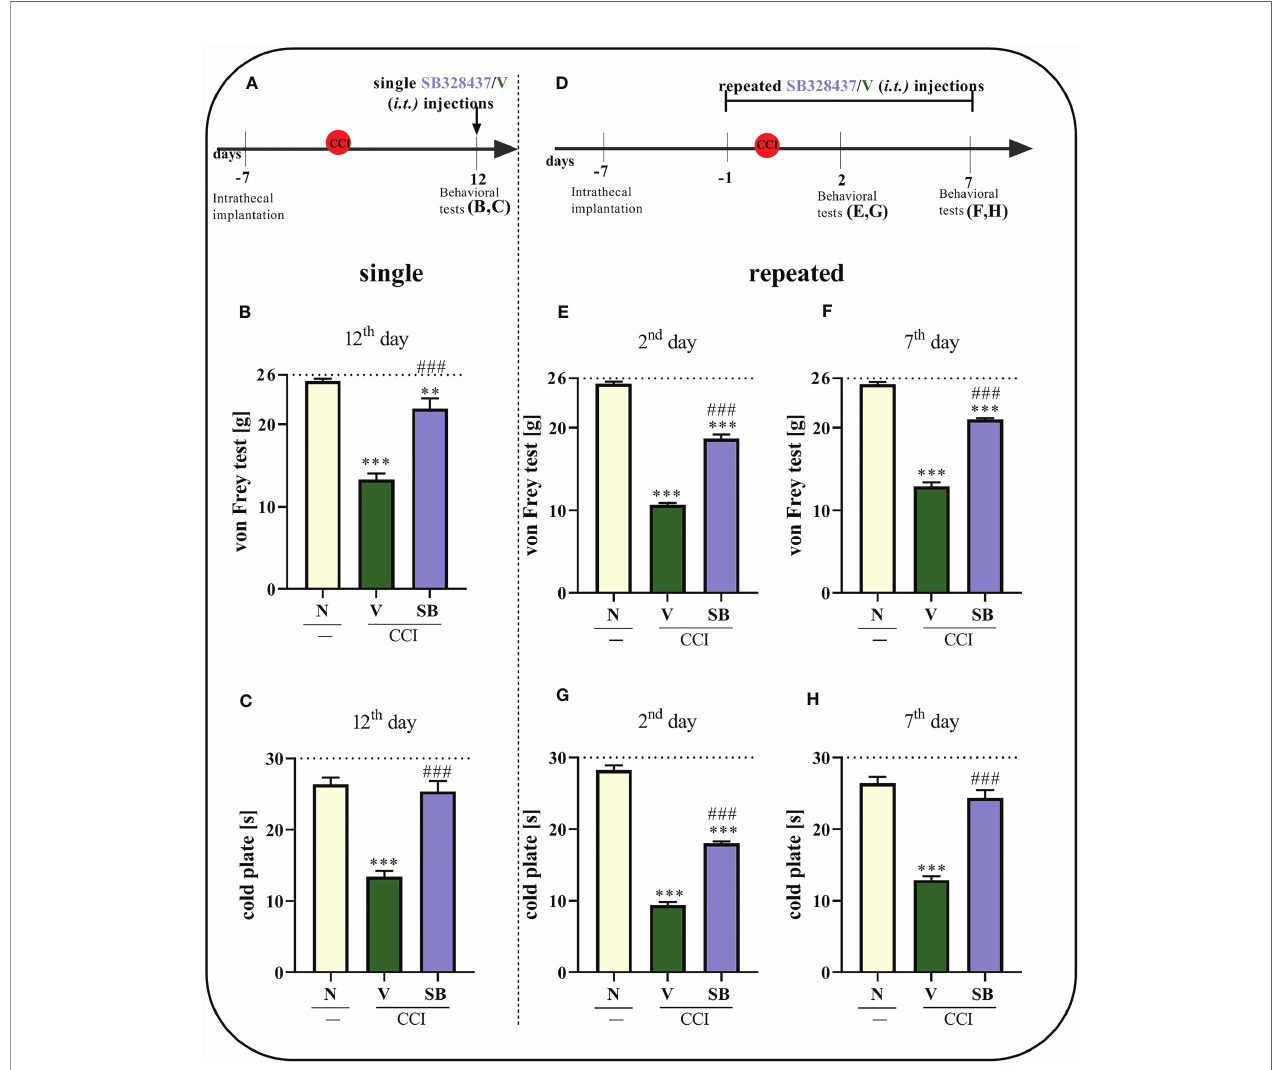
FIGURE 3 | Effect of a single administration of SB328437 [SB, 10 m g/5 m l; i.t . (A) ] on pain-related behaviors in rats on the 12 th day post- chronic constriction injury of the sciatic nerve (CCI), 3 h after drug injection [von Frey test- (B) ; cold plate test- (C) ] and repeated administration of SB in different group of rats, 16 h and 1 h before CCI and then once a day for 7 days on pain-related behaviors [10 m g/5 m l; i.t . (D) ] as measured 2 [von Frey test- (E) ; cold plate test- (G) ] and 7 [von Frey test- (F) ; cold plate test- (H) ] days after chronic constriction injury. The horizontal dotted line shows the cutoff value. The data are presented as the means ± SEM (7 – 10 rats per group). Intergroup differences were analyzed using ANOVA with Bonferroni ’ s post hoc test for multiple comparisons. **P < 0.01 and ***P < 0.001 indicate a signi fi cant difference compared with the control group (naive, N rats); ### P < 0.001 indicates a signi fi cant difference compared with the Vehicle (V)-treated